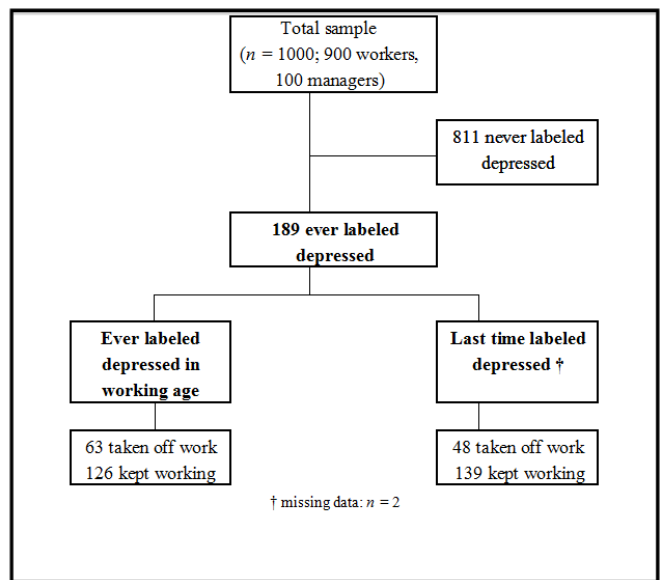
Figure 1. Survey chart for participant workers ( n =